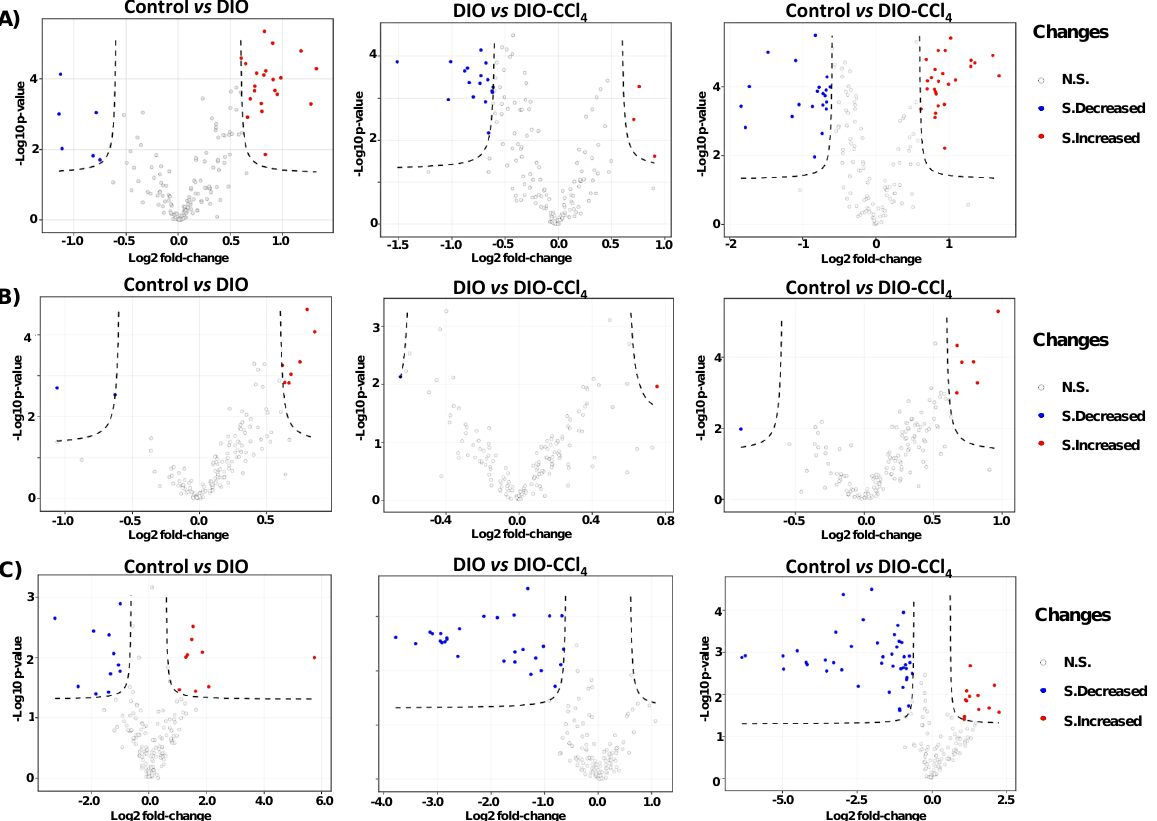
Figure 4. Volcano plots of metabolic features of liver ( A ), serum ( B ) and intestine content ( C